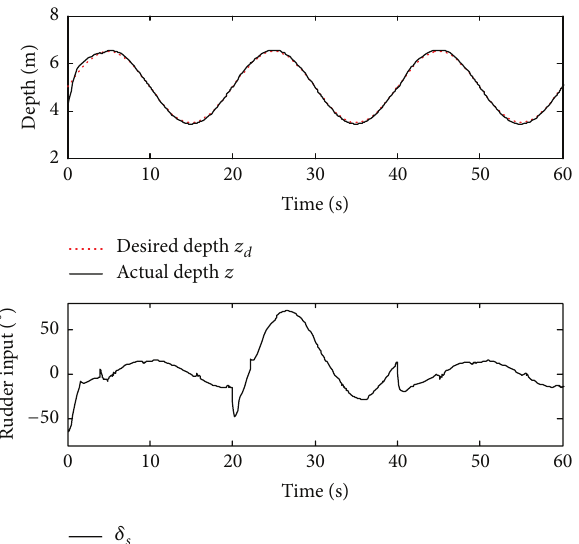
Figure 3: Depth trajectory and rudder input 𝛿 𝑠 of REMUS AUV.